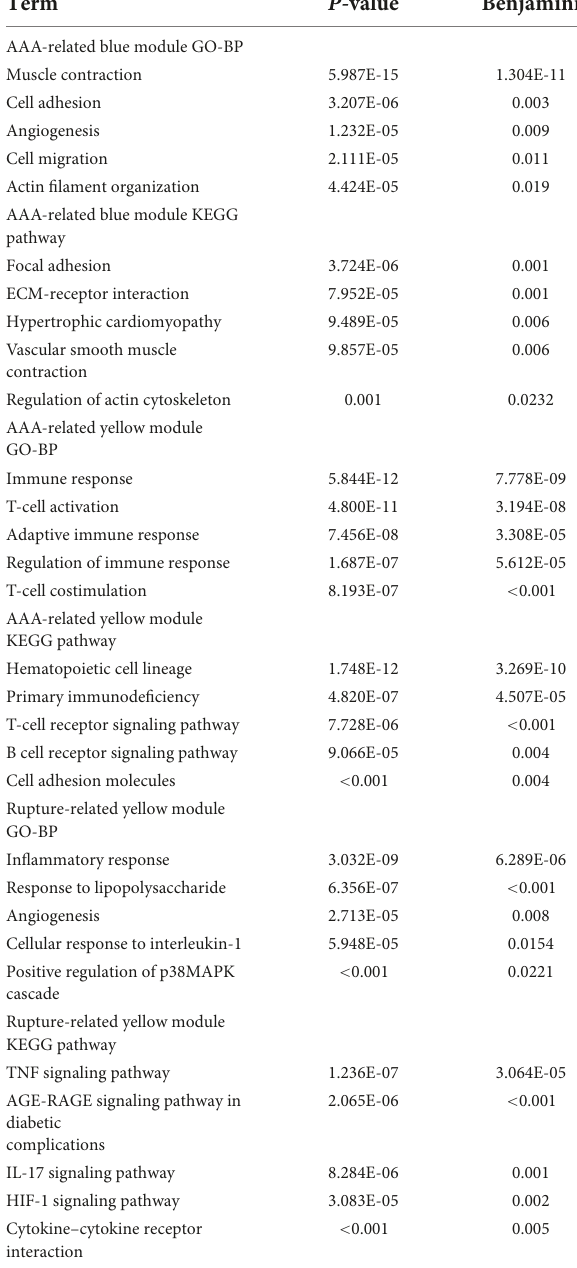
TABLE 1 Enrichment analysis of AAA and rupture-related gene